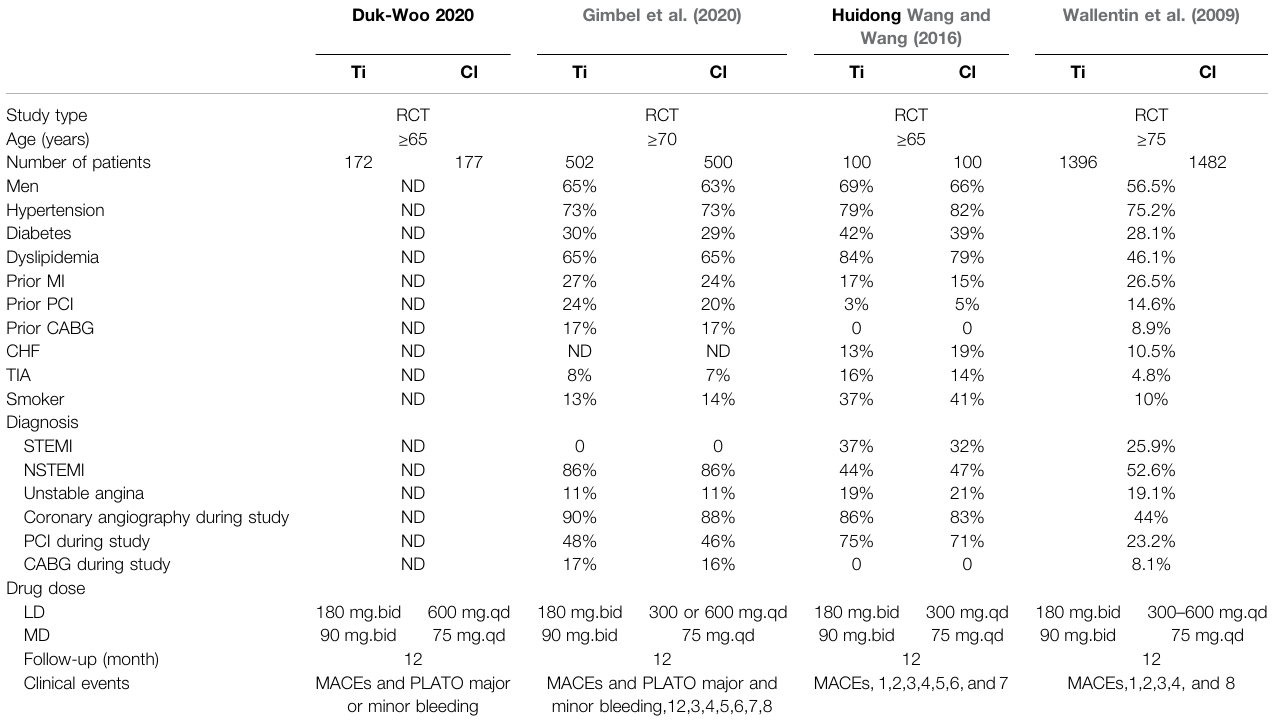
TABLE 1 | Characteristics of the included trials.